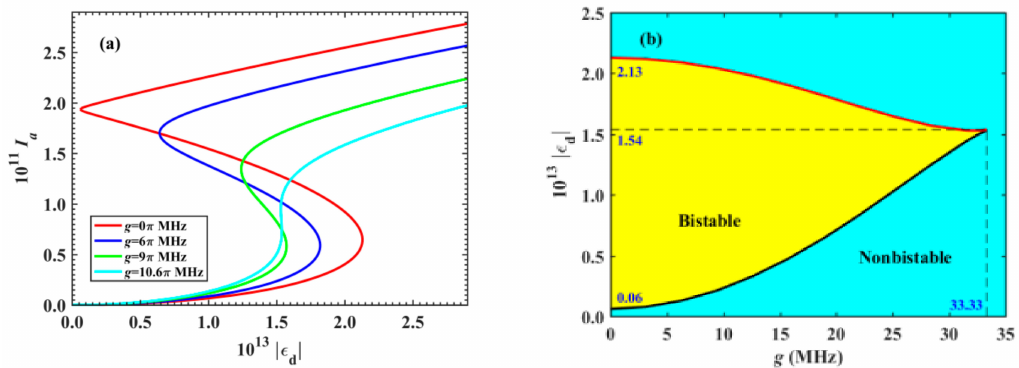
Figure 2. ( a ) Curves of the mean intracavity photon number versus the intensity of the pump field under the condition of di ff erent coupling of cavity-atom. ( b ) The relation of bistable region and the coupling of cavity-atom. Where γ 13 = γ 12 = γ 14 = γ , ∆ 1 = γ , ∆ 2 = ∆ 3 = 2 γ , ∆ 0 = 20 γ , Ω = Ω = 4.5 Ω 2 0 1